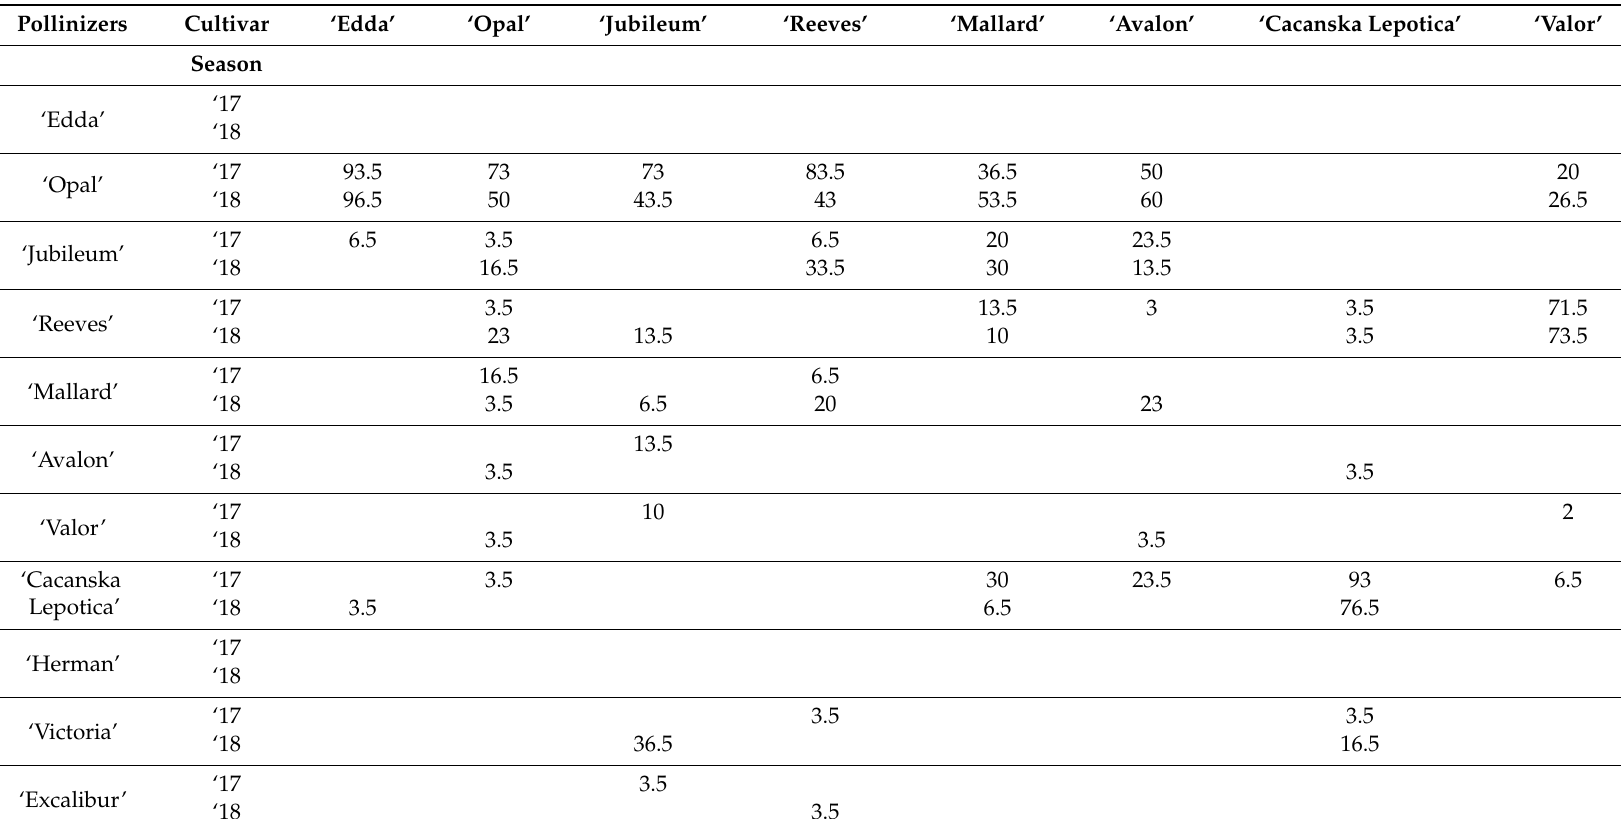
Table 4. Success rate of 11 pollinizers (expressed in percentage) among eight plum cultivars, calculated during two seasons in nine orchards, located in Ullensvang, Norway. The data for calculation was obtained through genotyping of 480 plum embryos, using seven SSR markers, and consequent positive identification of pollen